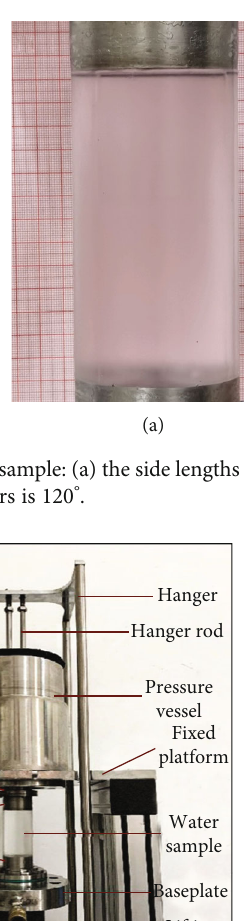
Figure 2: Fabrication process for the water sample package, including (a) the composition of the assembly cylinder and (b) the completed state of the water sample package.